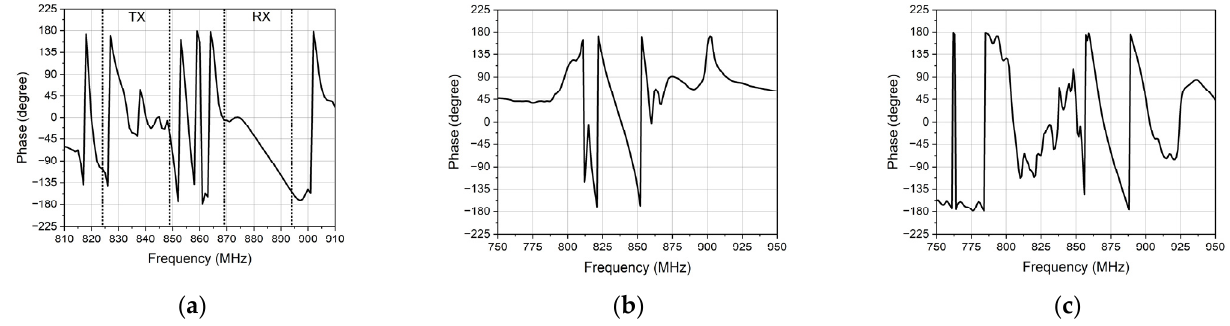
Figure 4. Different phases. ( a ) The phase of TX to RX. ( b ) The phase of the ladder type. ( c ) The phase of the DMS.